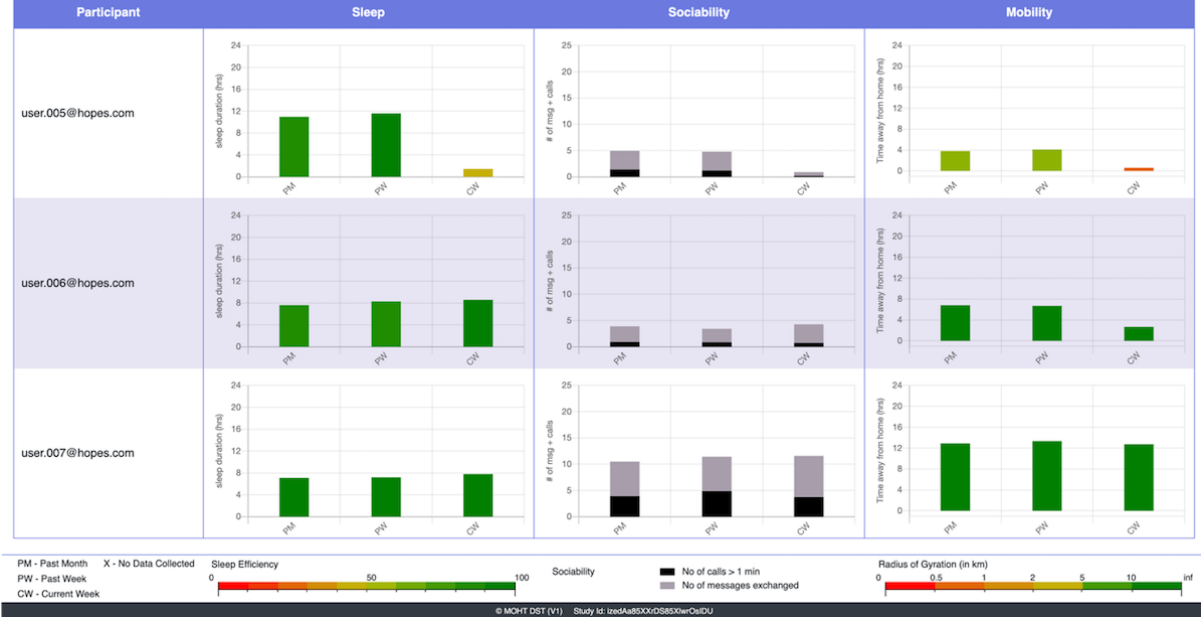
Figure 4. The clinician dashboard shows a preview of general trends in patient biomarker